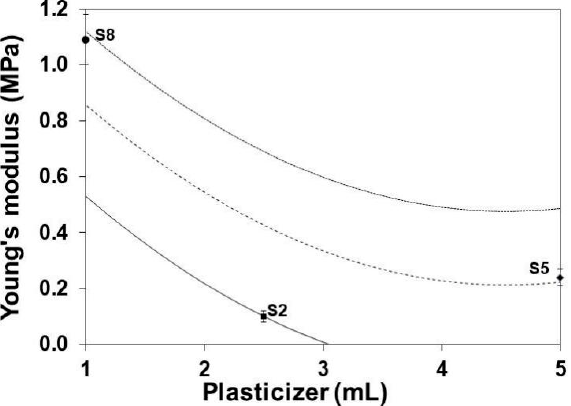
Figure 4. Effect of plasticizer on the YM of SLGMs varying the gelatin content: 1.0 g (continuous), 2.5 g (dashed) and 5.0 g (dotted). Experimental points: S2, S5 and S8. Conditions: water content = 50 mL; maturation time = 7.5 min.